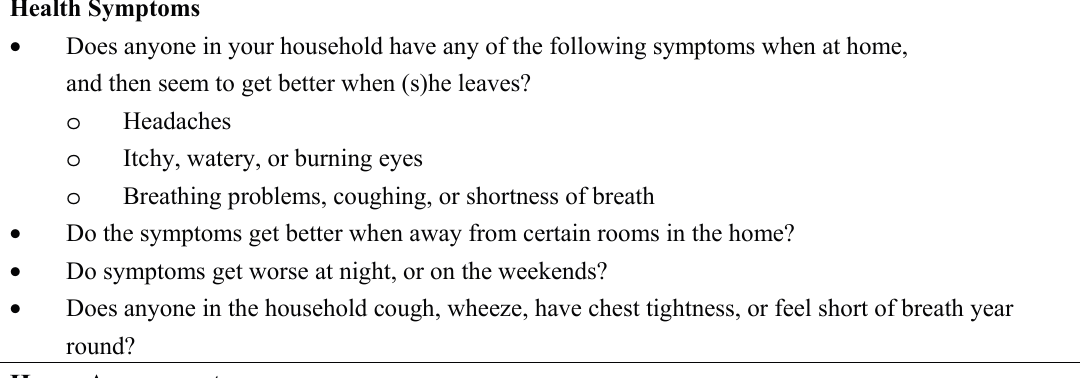
Table 1. Healthy homes intake